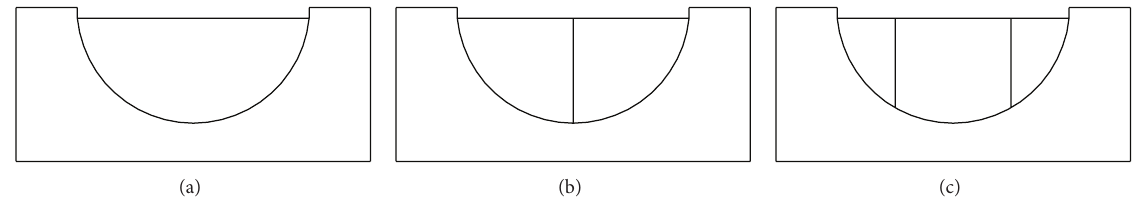
Figure 2: Scale models identified by number of contraction joints. Model I (a), Model II (b), and Model III (c).